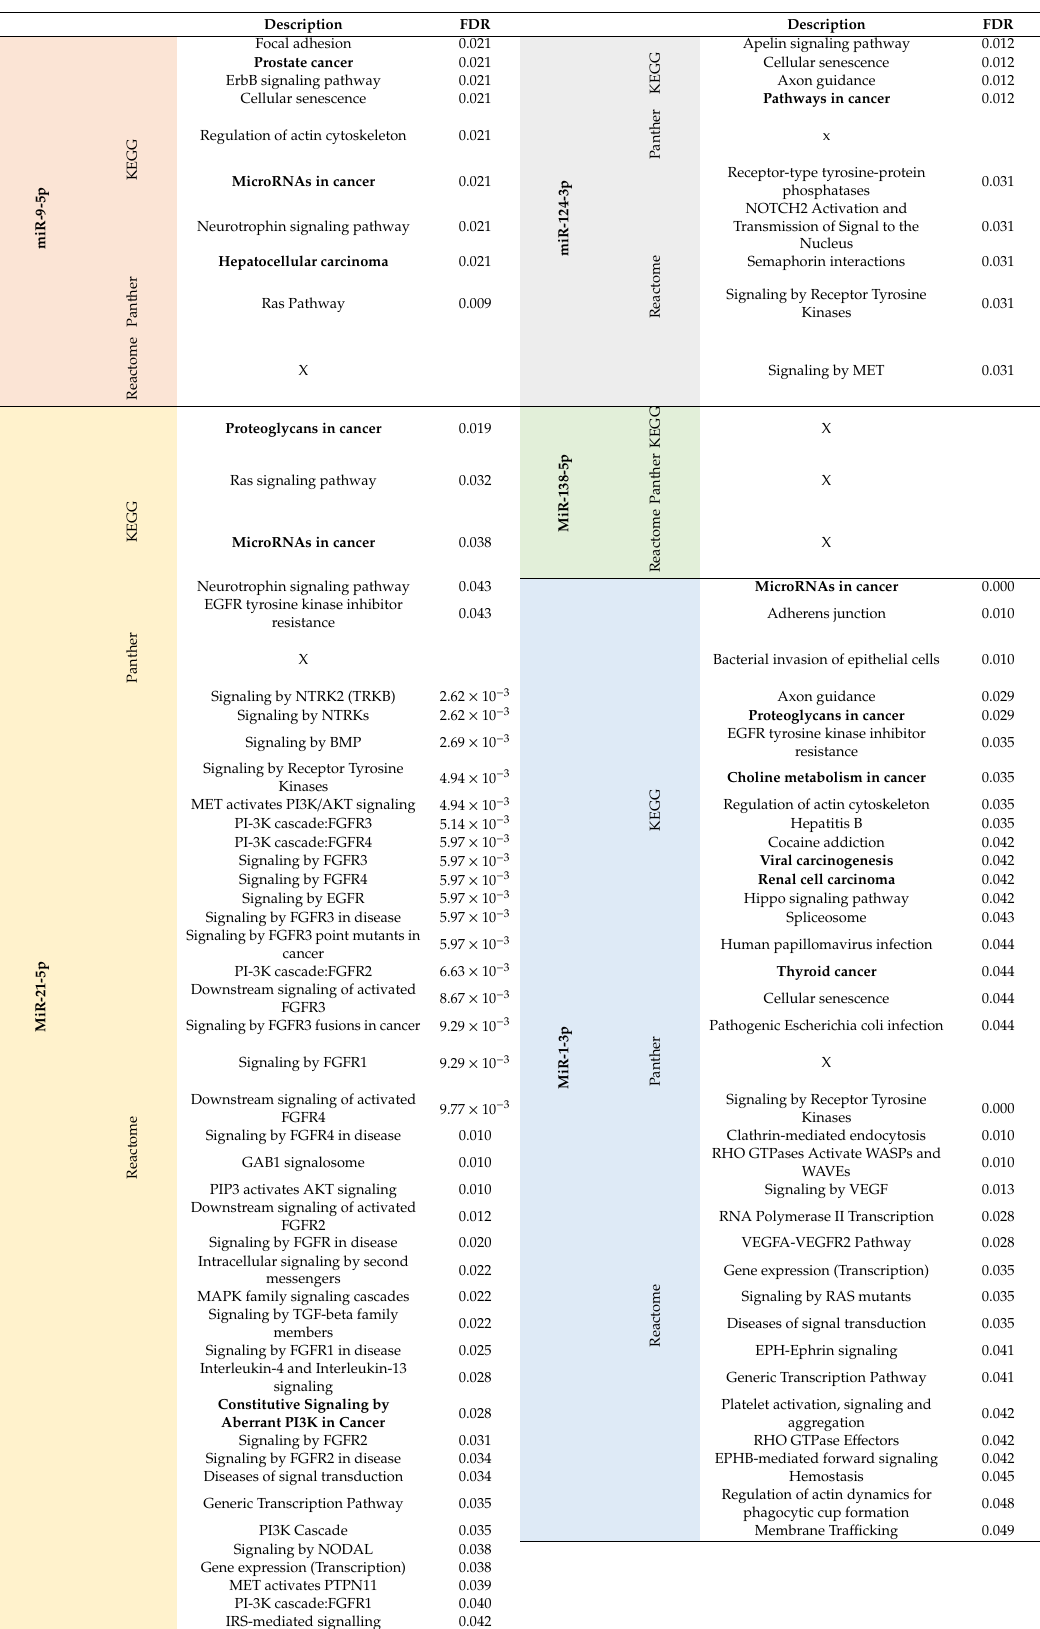
Table2. Pathway analysis of common genes analyzed by WebGestalt (KEGG, Panther, and Reactome